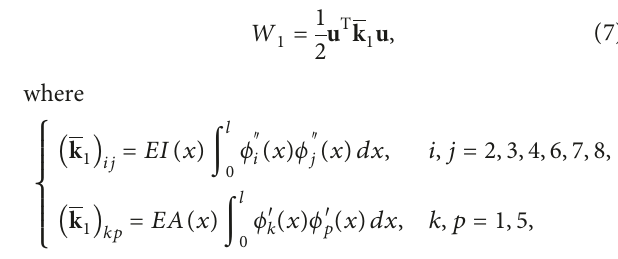
Figure 1: Schematic diagram of the cracked beam